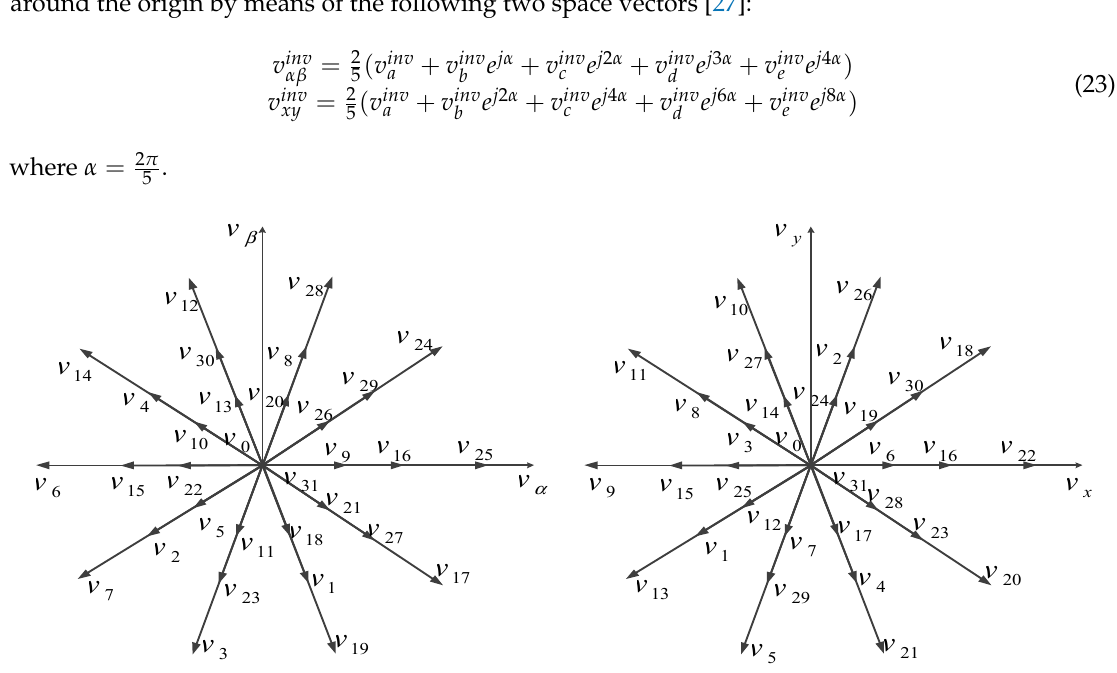
Figure 4. Space vectors of a five-phase inverter in two 2-D subspaces.